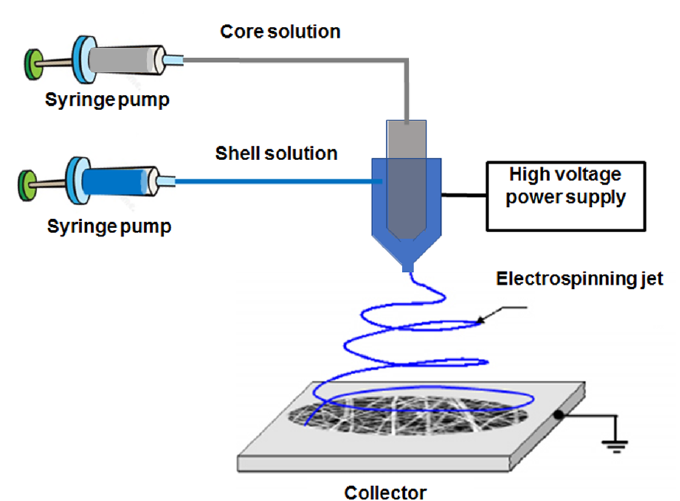
Figure 1. Schematic representation of the coaxial electrospinning setup. In this example the core solution is composed by the PTX dissolved in 2,2,2-trifluoroethanol and the shell solution is the poly(L-lactic acid-co- ε -caprolactone) polymer. Reprinted with permission from reference [27]. Copyright Wiley Online Library, 2009.